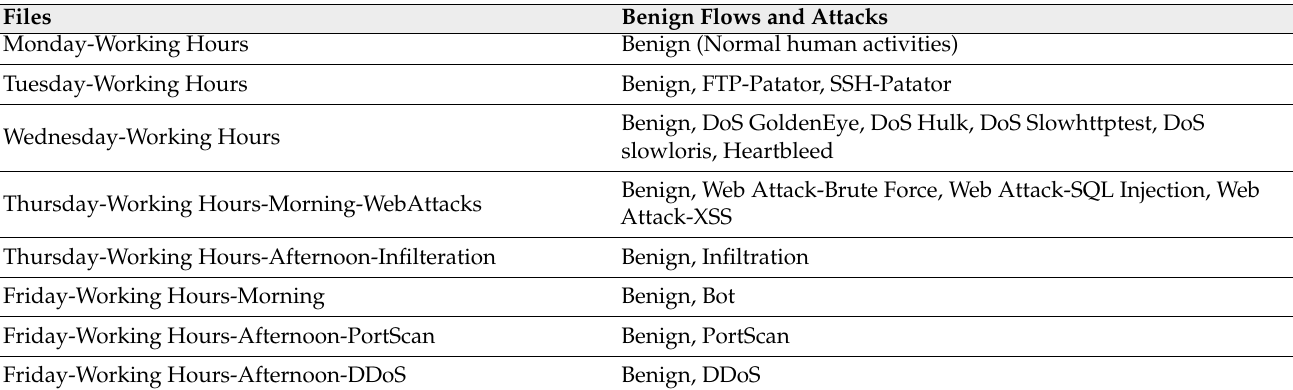
Table 1. Description of files and flows included in the CICIDS2017